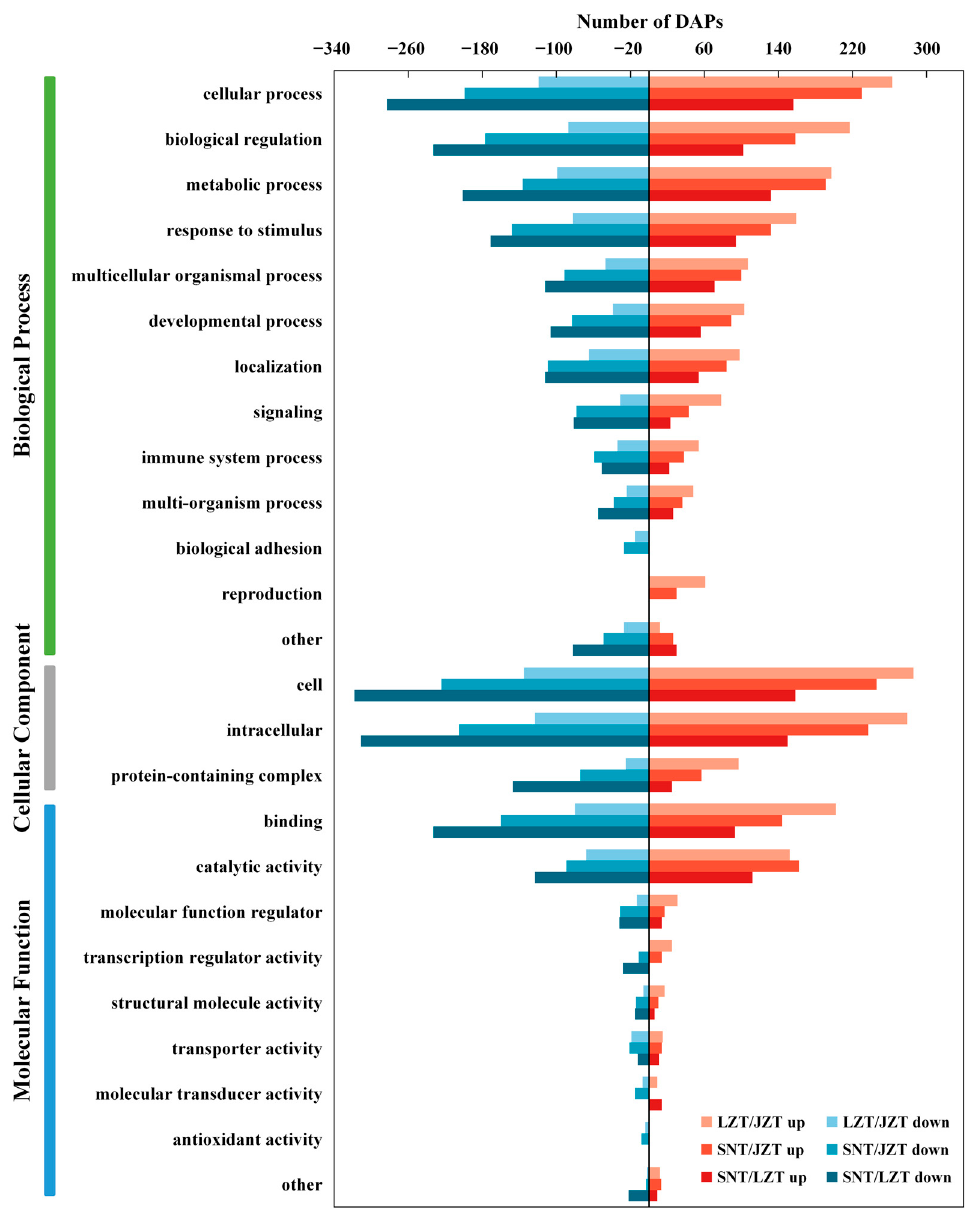
Figure 3. GO annotation of DEPs in LZT/JZT, SNT/JZT and SNT/LZT.